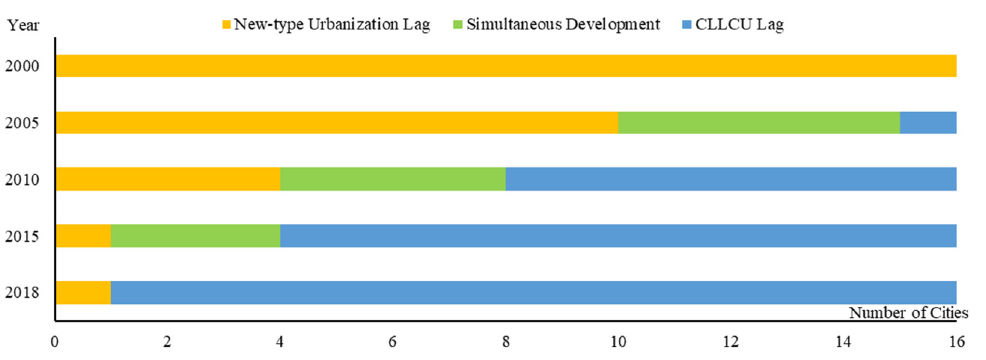
Figure 10. The type of relative development between new-type urbanization and cultivated land low-carbon utilization of the Yangtze River Delta during 2000–2018.